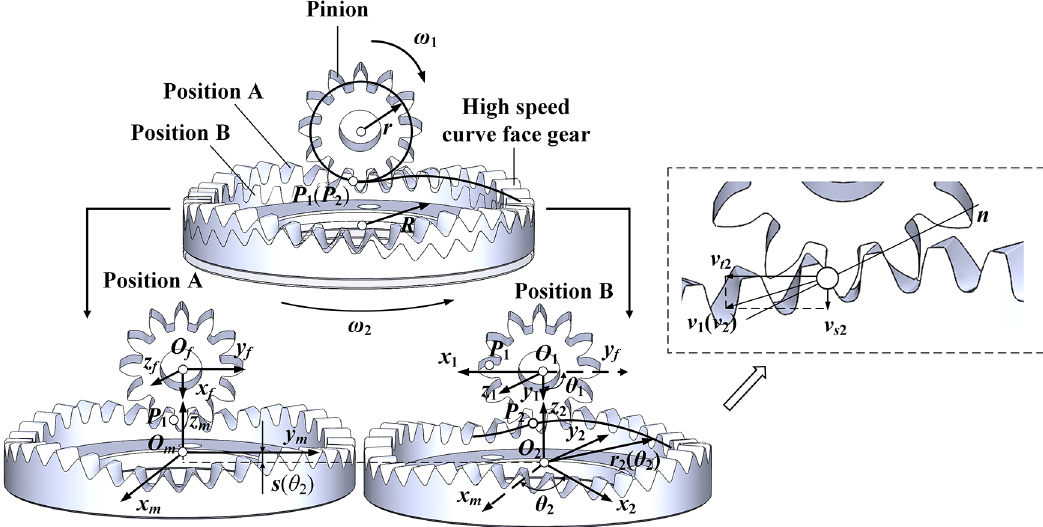
Fig. 2. Composite motion principle of gear pair.